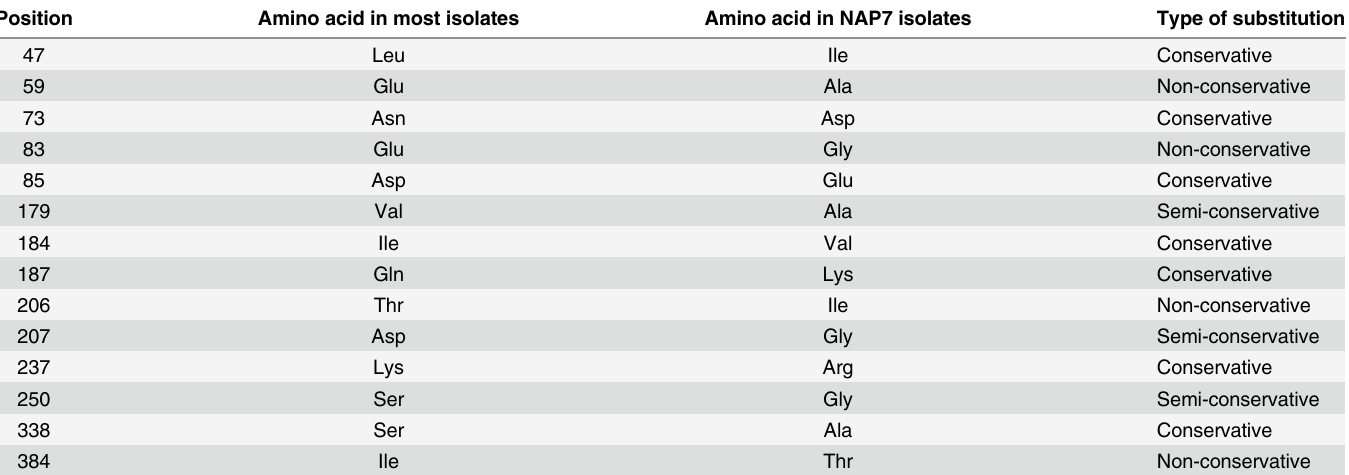
Table 3. Amino acid substitutions in CspC protein sequences of NAP7 isolates.